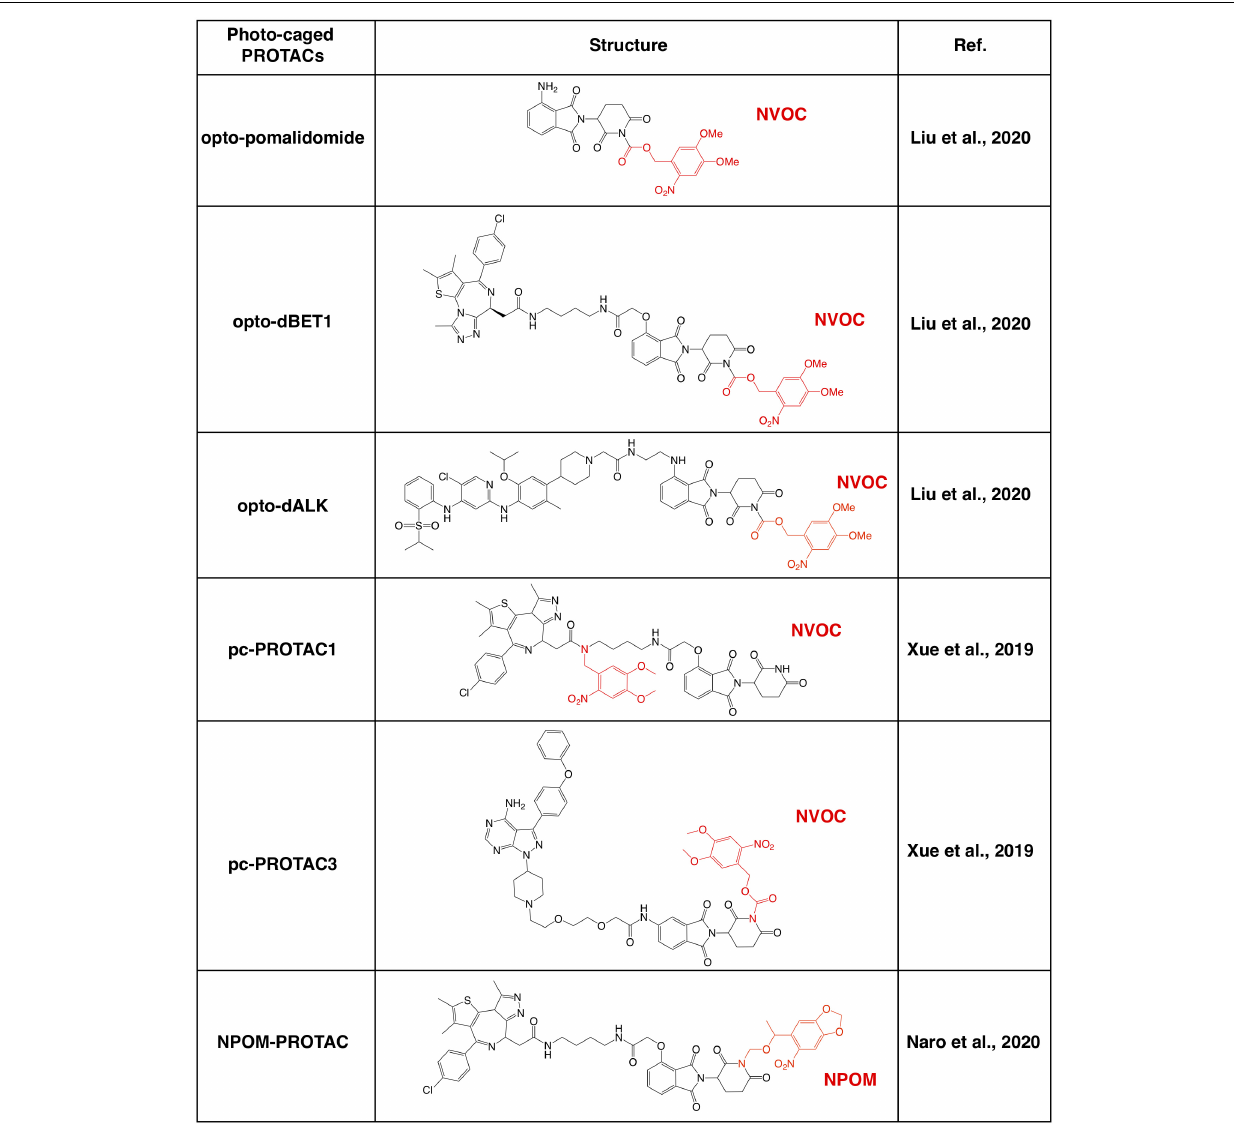
FIGURE 3 | Summary of photo-caged CRBN-based PROTACs. The photo-cage groups are marked in red. NVOC, nitroveratryloxycarbonyl; NPOM,